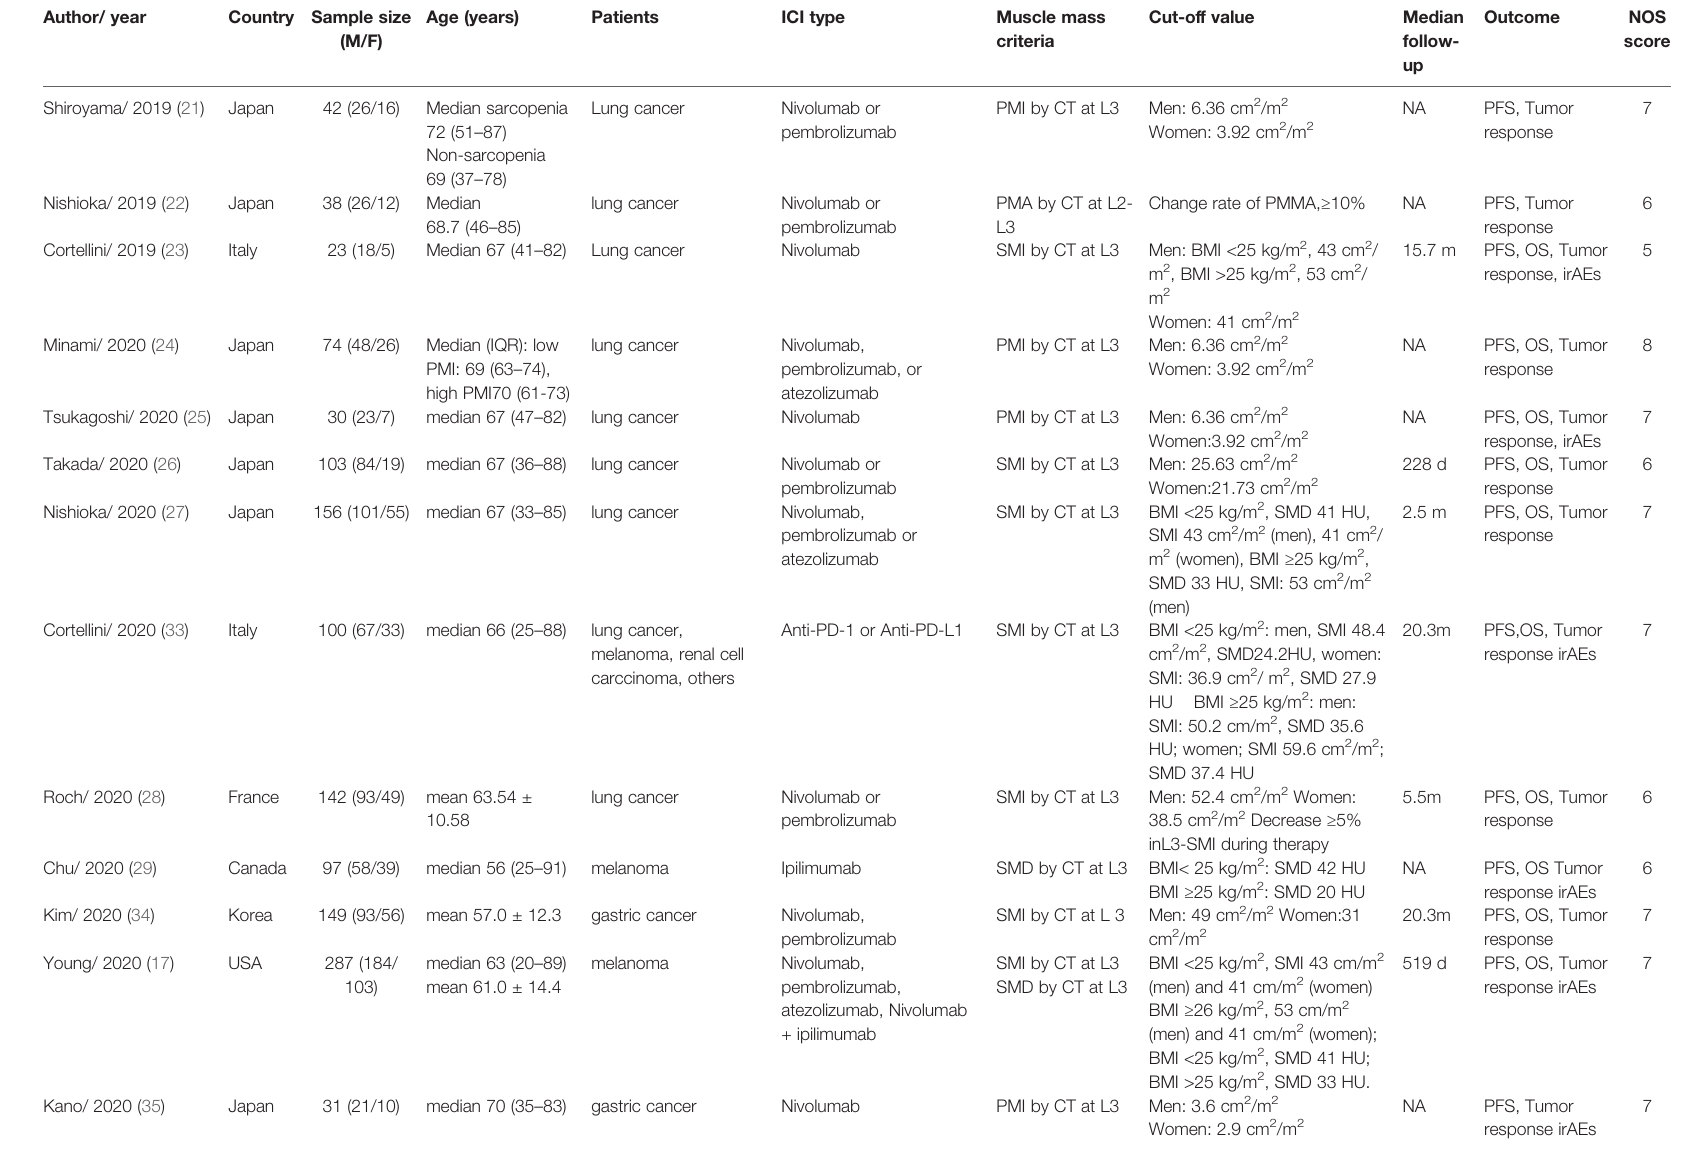
TABLE 1 | Characteristics of the included